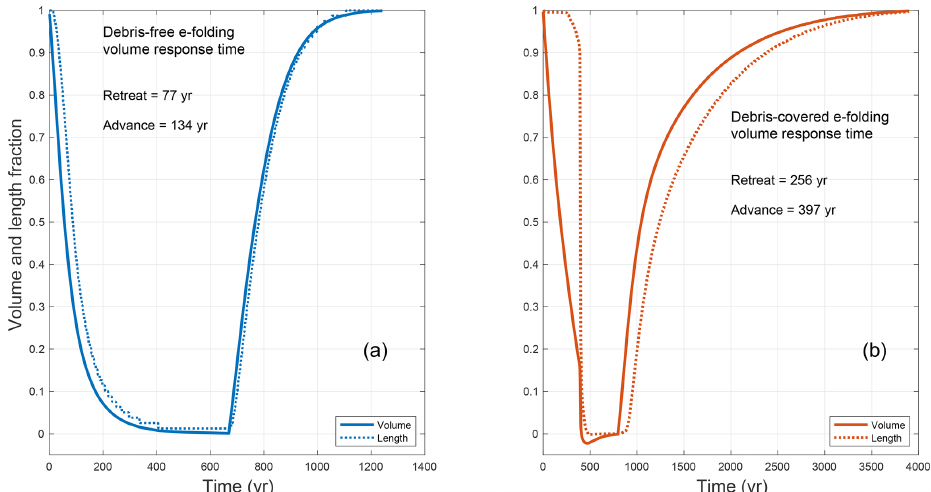
Figure 4. Normalized transient volume and length response for a step change in ELA between two steady states for (a) a debris-free glacier and (b) a debris-covered glacier with c = 0 .